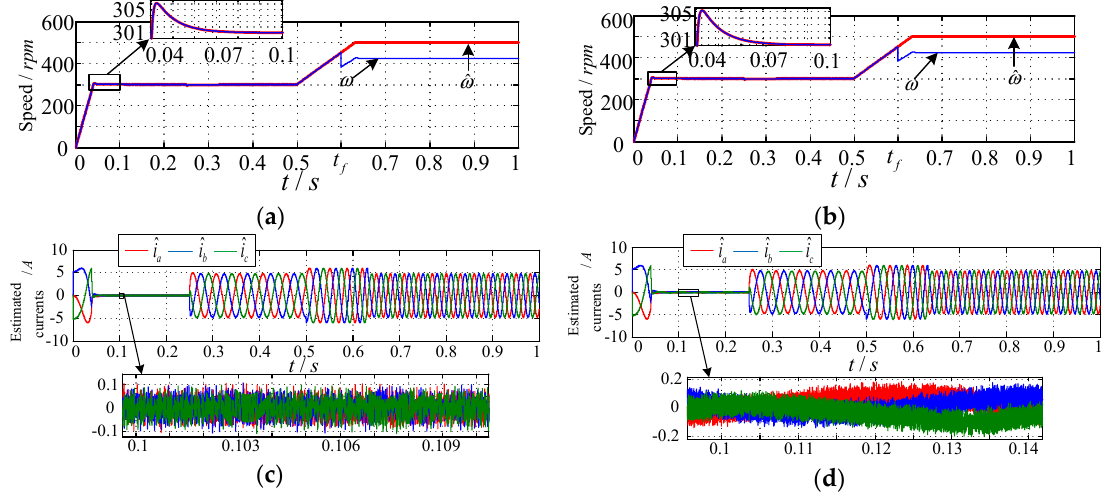
Figure 10. The observed signal output waveforms of two types of system in the case of speed sensor constant gain fault. ( a ) The measured speed ω and estimated speed ˆ ω based on composite sliding mode observer; ( b ) The measured speed ω and estimated speed ˆ ω based on Luenberger observer (Multi-observer system); ( c ) The estimated current ˆ i abc based on composite sliding mode observer; ( d ) The estimated current ˆ i abc based on traditional sliding mode observer (multi-observer system).